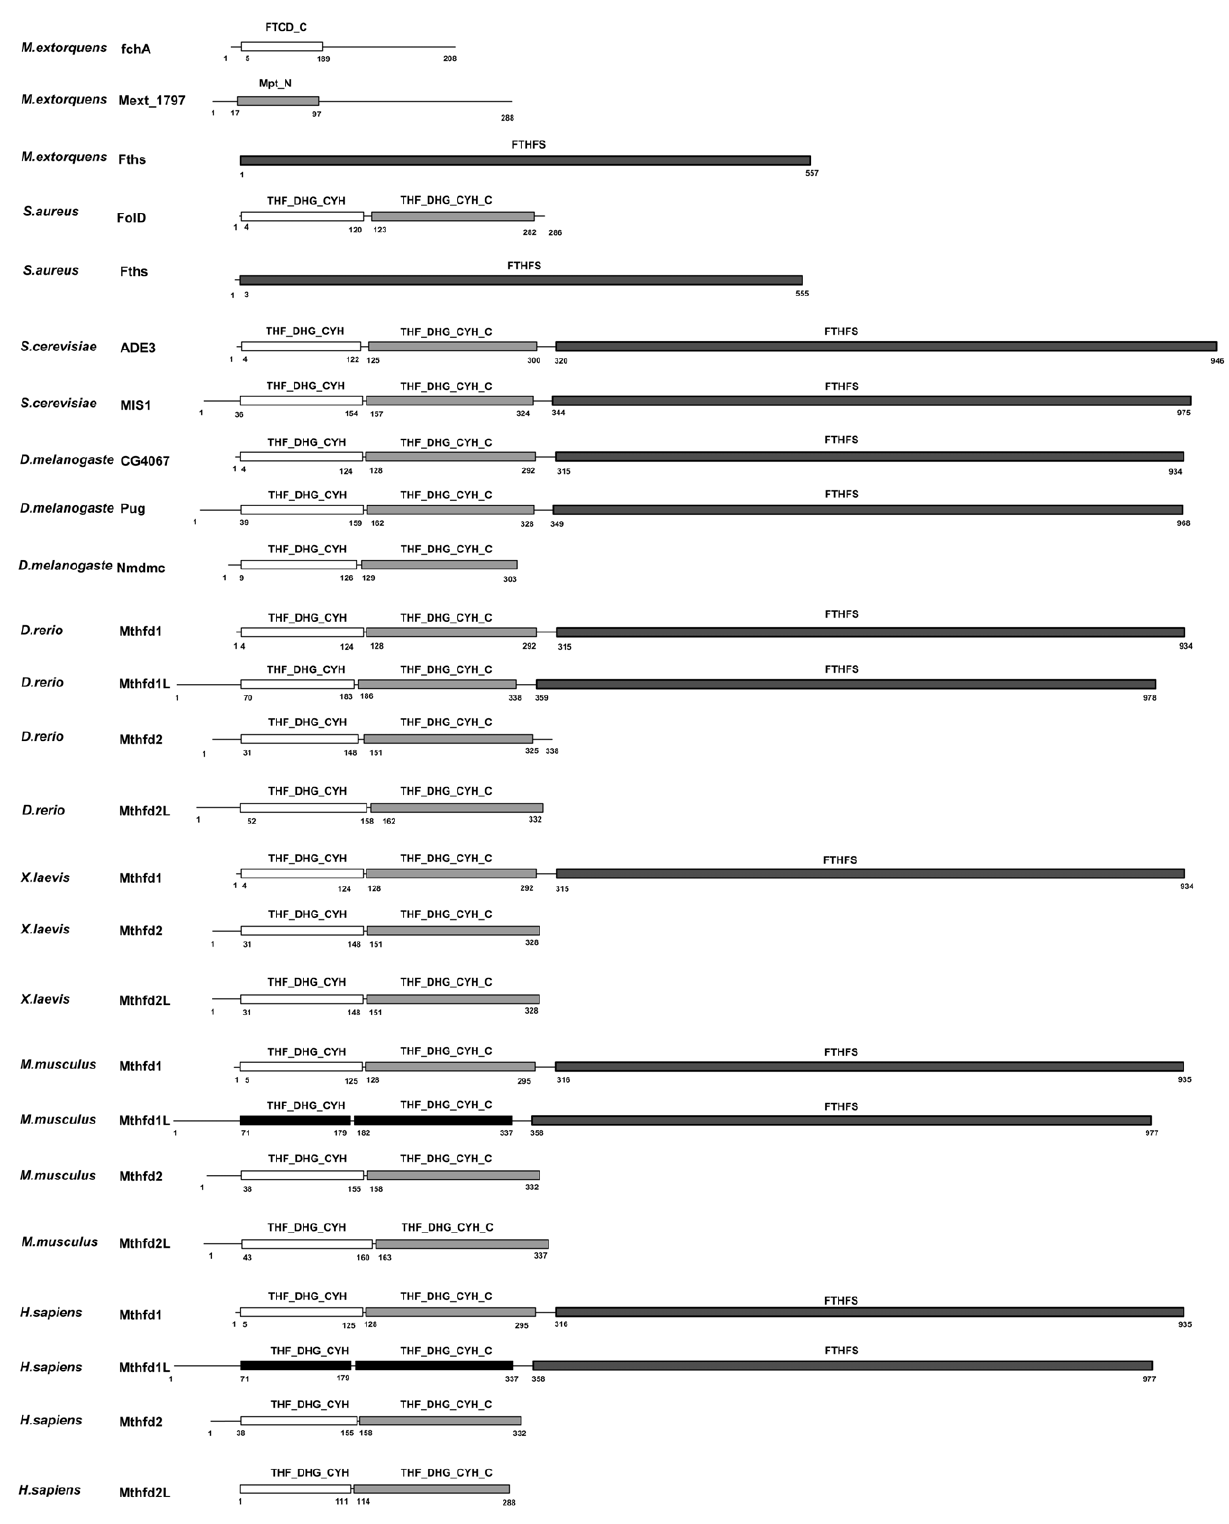
Figure 2. The evolution path of C-1-tetrahydrofolate synthase in eukaryotic representatives including M.extorquens , S.aureus , S.cerevisiae , D.melanogaster , D.rerio , X.laevis , M.musculus , H.sapiens . It illustrated how three independent proteins (domains) fused and mutated during the evolutionary path, which resulted in the gain and loss of multiple-functionality. The THF_DHG_CYH and THF_DHG_CYH_C domains of human and mouse Mthfd1L proteins illustrated in dark block of net pattern were mutated and lost tetrahydrofolate dehydrogenase/ cyclohydrolase activities.